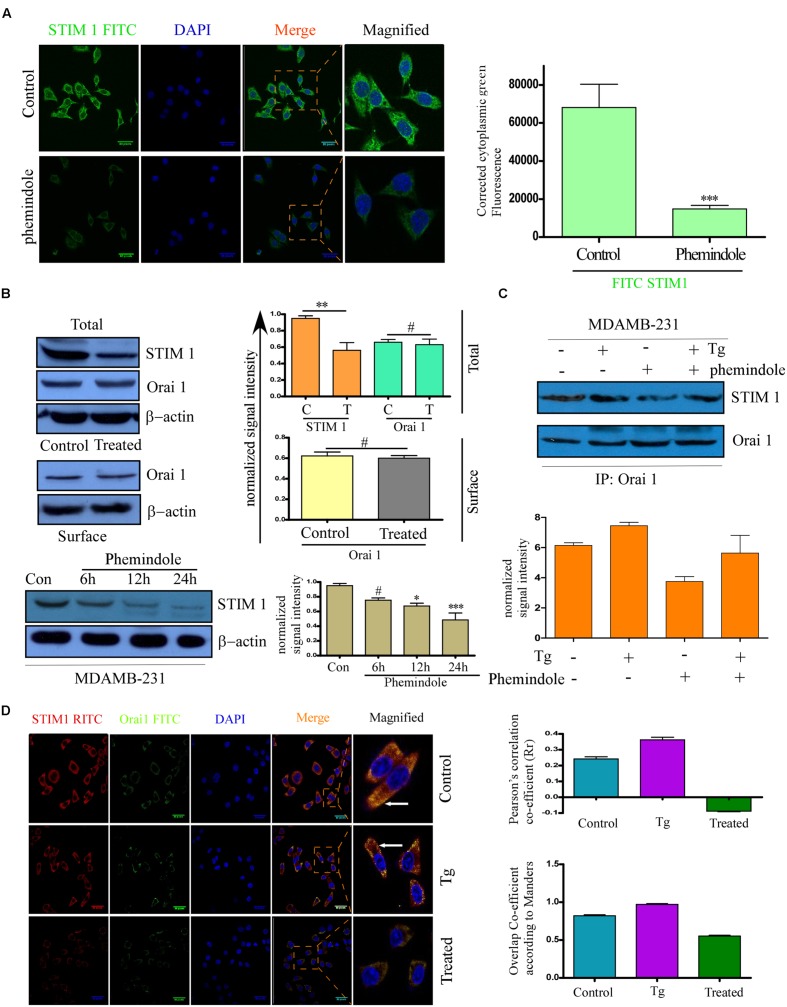
Phemindole downregulates STIM1 Expression.
(A) Immunofluorescence images showing decreased expression of STIM1 in the MDAMB-231 cells in response to Phemindole treatment. Anti STIM1 antibody was FITC tagged (green) and nuclei were stained with DAPI (blue) (left panel). Corrected Fluoroscence intensity of STIM1 protein was quantified and represented as bar diagram (Right panel). Pictures showed representative cells of each population and were representative of three independent experiments. (B) Western blot analysis depicting the changes in the expression pattern of STIM1 and Orai1. MDAMB-231 cells were treated with Phemindole and Western blotted with respective antibodies as labeled in the figure (upper-left panel). Quantification of WB were depicted as bar diagram (upper-right panel). MDAMB-231 cells were treated with 10 μM Phemindole for 24 h. Lysates were subjected to SDS–PAGE followed by Western blotting (with anti-Orai1 antibodies. β–actin was used as a loading control (middle-left panel). Band intensity was quantified and represented as a bar histogram (middle-right panel). Cells were treated with 10 μM Phemindole and were harvested at 0, 6, 12, or 24 h after Phemindole treatment. Western blotting was done. Antibodies used are labeled and β-actin was used as loading control (lower-left panel). Lower-right panel represent the normalized intensity of the bands. Blots are representative of three independent experiments and quantifications are indicated by Bar diagram. Values were normalized by intensity of loading control. (C) MDAMB-231 cells were treated with Phemindole or Tg under different conditions, lysed and proteins were subjected to immune precipitation by anti STIM1 antibody and followed by Western blotting with respective antibody (upper panel). (D) Representative Fluorescence images showed the association between STIM1 (red) and ORAI1 (green) at plasma membrane. Nuclei were stained with DAPI (blue). Enlargements of the areas indicated by the color rectangles showed overlap formation of STIM1 and Orai1 in plasma membrane due to Tg treatment (Left-middle) which is invisible in Phemindole treated set (left-lower) and not prominent in un-stimulated control set (left-upper panel). Pictures showed representative cells of each population and were representative of three independent experiments. Right panel, the Pearson’s and Manders coefficients determining the level of overlap of RITC and FITC on treatment with Control, thapsigargin (TG) and Phemindole has been represented graphically. ∗,∗∗,∗∗∗,# indicate p < 0.05, p < 0.01, p < 0.0005, p > 0.05 respectively versus untreated or control group.)